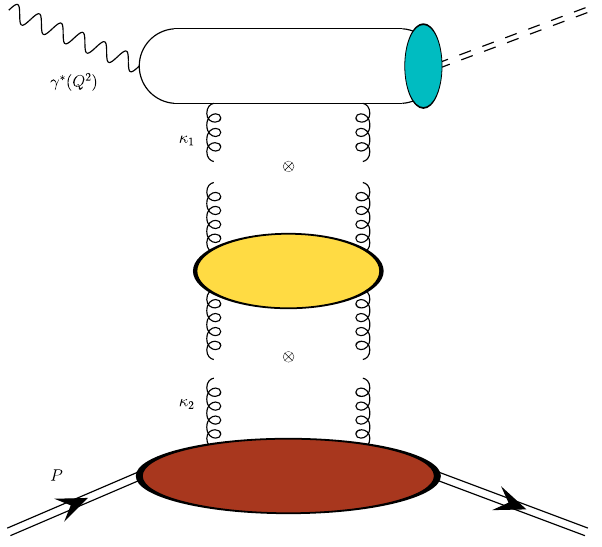
Fig. 1 Diagrammatic representation of the amplitude for the exclusive emissionofa ρ mesoninhigh-energyfactorization.Theoff-shellimpact factor(upperpart)isbuiltupasacollinearconvolutionbetweenthehard factor for the photon splitting to a dipole and the non-perturbative ρ - mesonDA(sea-greenblob).TheUGDisgivenbytheconvolutionofthe BFKL gluon Green’s function (yellow blob) and the non-perturbative proton impact factor (red